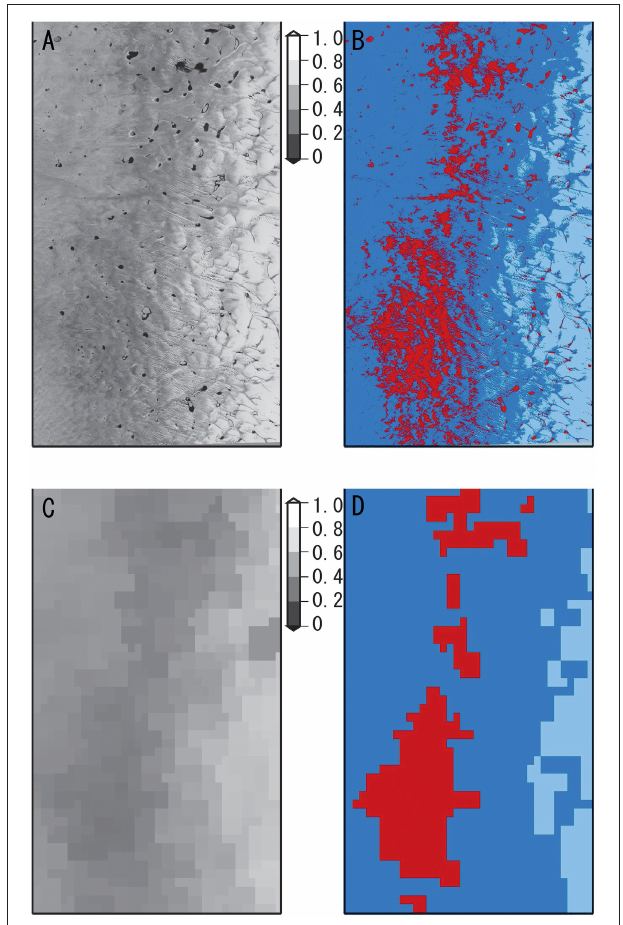
FIGURE 2 | Comparison of reflectance image ( λ = 0.66 µ m) and distribution of snow (light blue), bare ice (blue), and dark ice (red) between Landsat 8/OLI (A,B) and MODIS (C,D) satellites acquired on 12 July 2014.